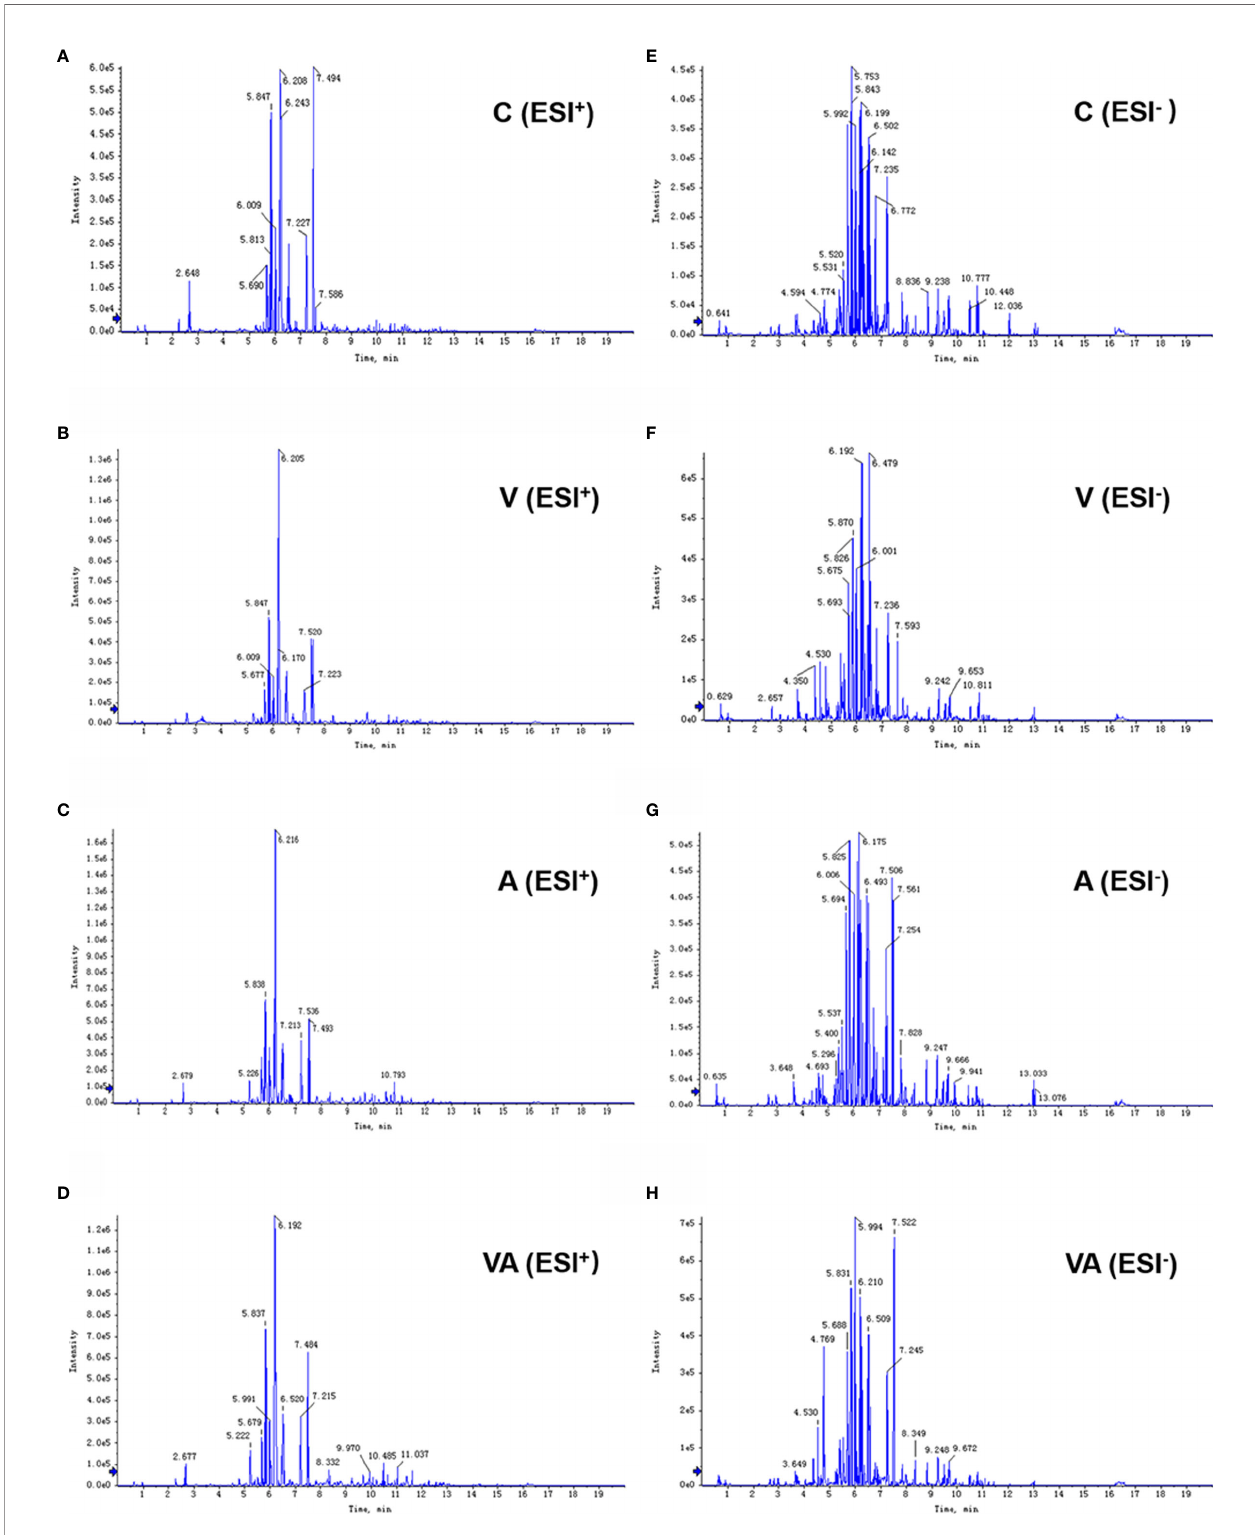
FIGURE 2 | Typical chromatograms of TIC in serum samples. TIC of group C (A) , V (B) , A (C) , and VA (D) in ESI + mode. TIC of group C (E) , V (F) , A (G) , and VA (H) in ESI −